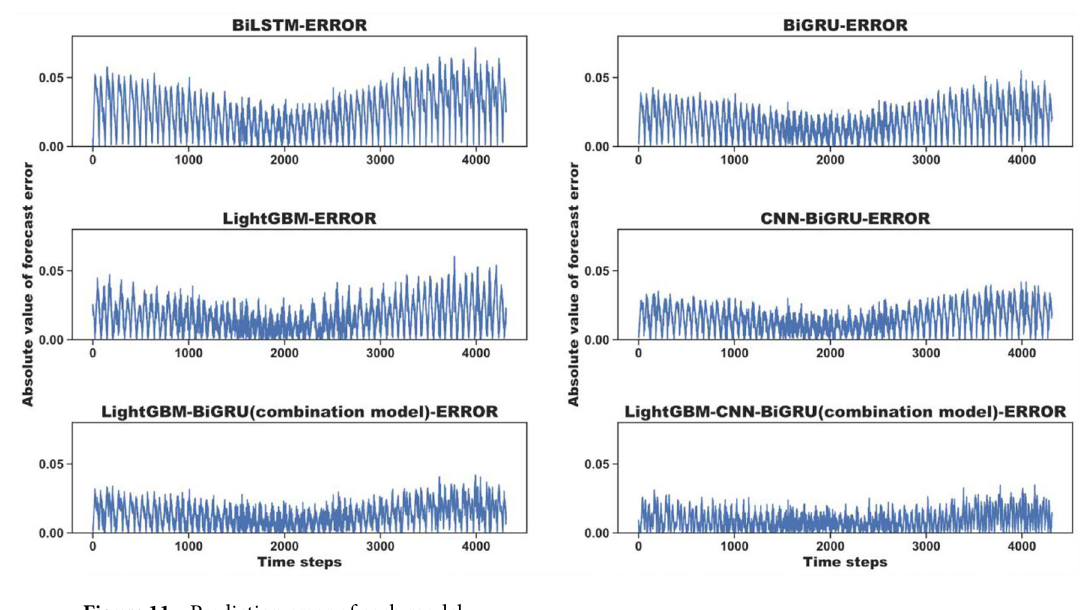
Figure 11. Prediction error of each model.